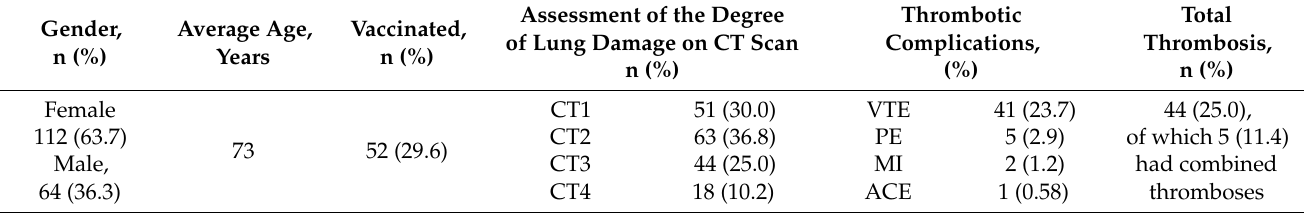
Table 2. Characteristics of patients.